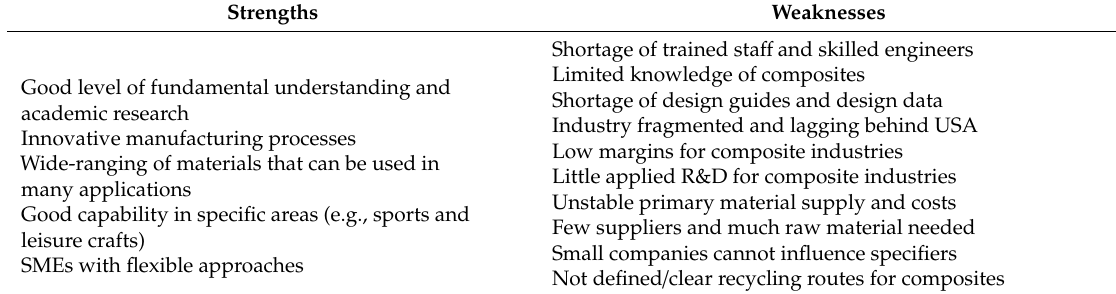
Table 2. SWOT analysis [93].